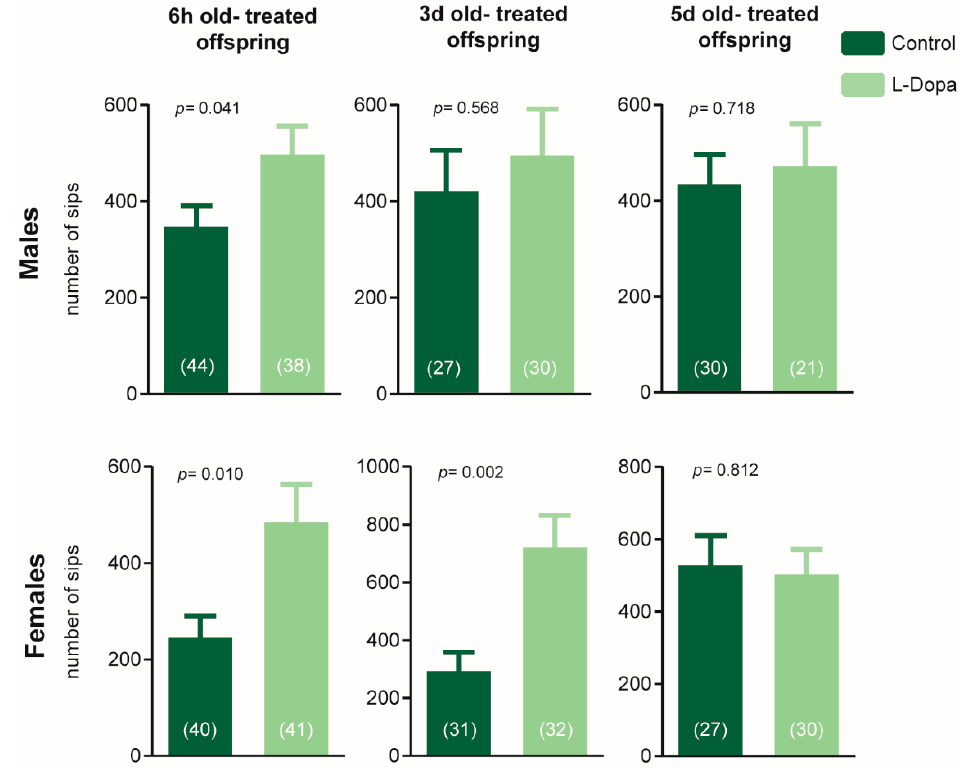
Figure 2. Parental dopaminergic administration 6 h and 3 days post-eclosion generates offspring overeating. The offspring of transiently-treated flies with levodopa after 6 h post-eclosion and the female progeny of 3 days old-treated flies display significantly increased feeding behavior (Student t -test; alpha = 0.05). No differences can be observed in the male descendants of 3 days old -treated flies and in the 5 days old -treated offspring. Bars and errors represent mean ± SEM, and the sample size for each group is given within brackets.